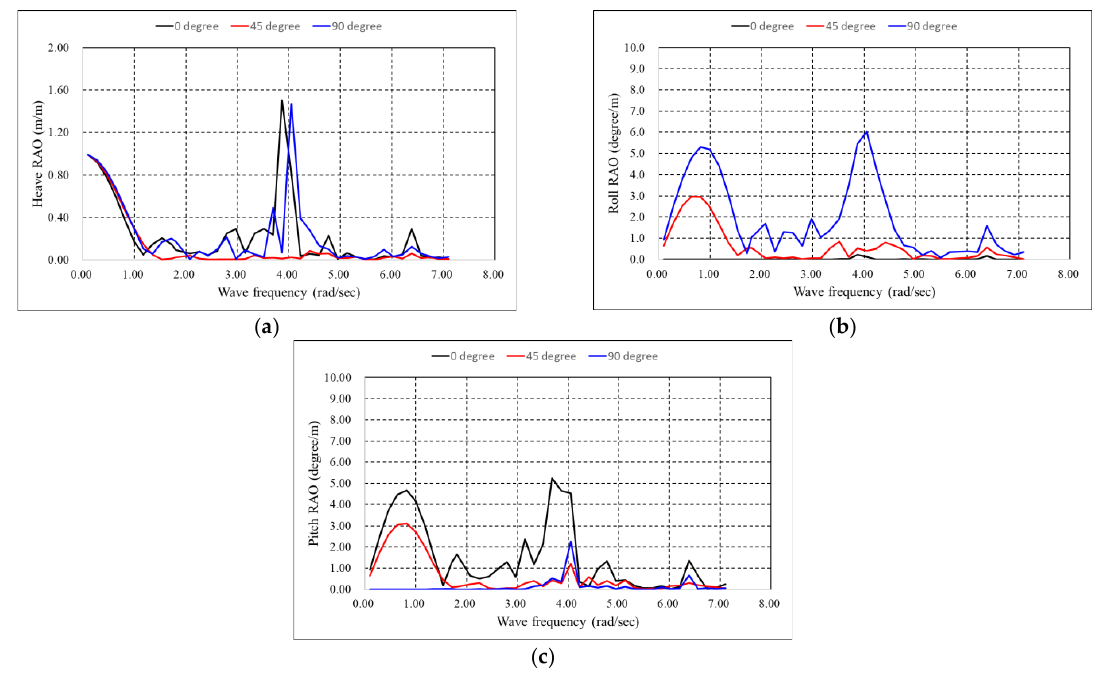
Figure 5. Motion RAOs: ( a ) heave; ( b ) roll; ( c ) pitch. The impulse response functions for heave, roll, and pitch motion were listed in Figure 6, which represents the wave radiation damping force at the time t resulting from a unit impulse in velocity at the time zero. Then, the wave radiation damping force decays to zero at 30 s. The convolution between the impulse response functions and velocity gives wave loads to structural analysis.